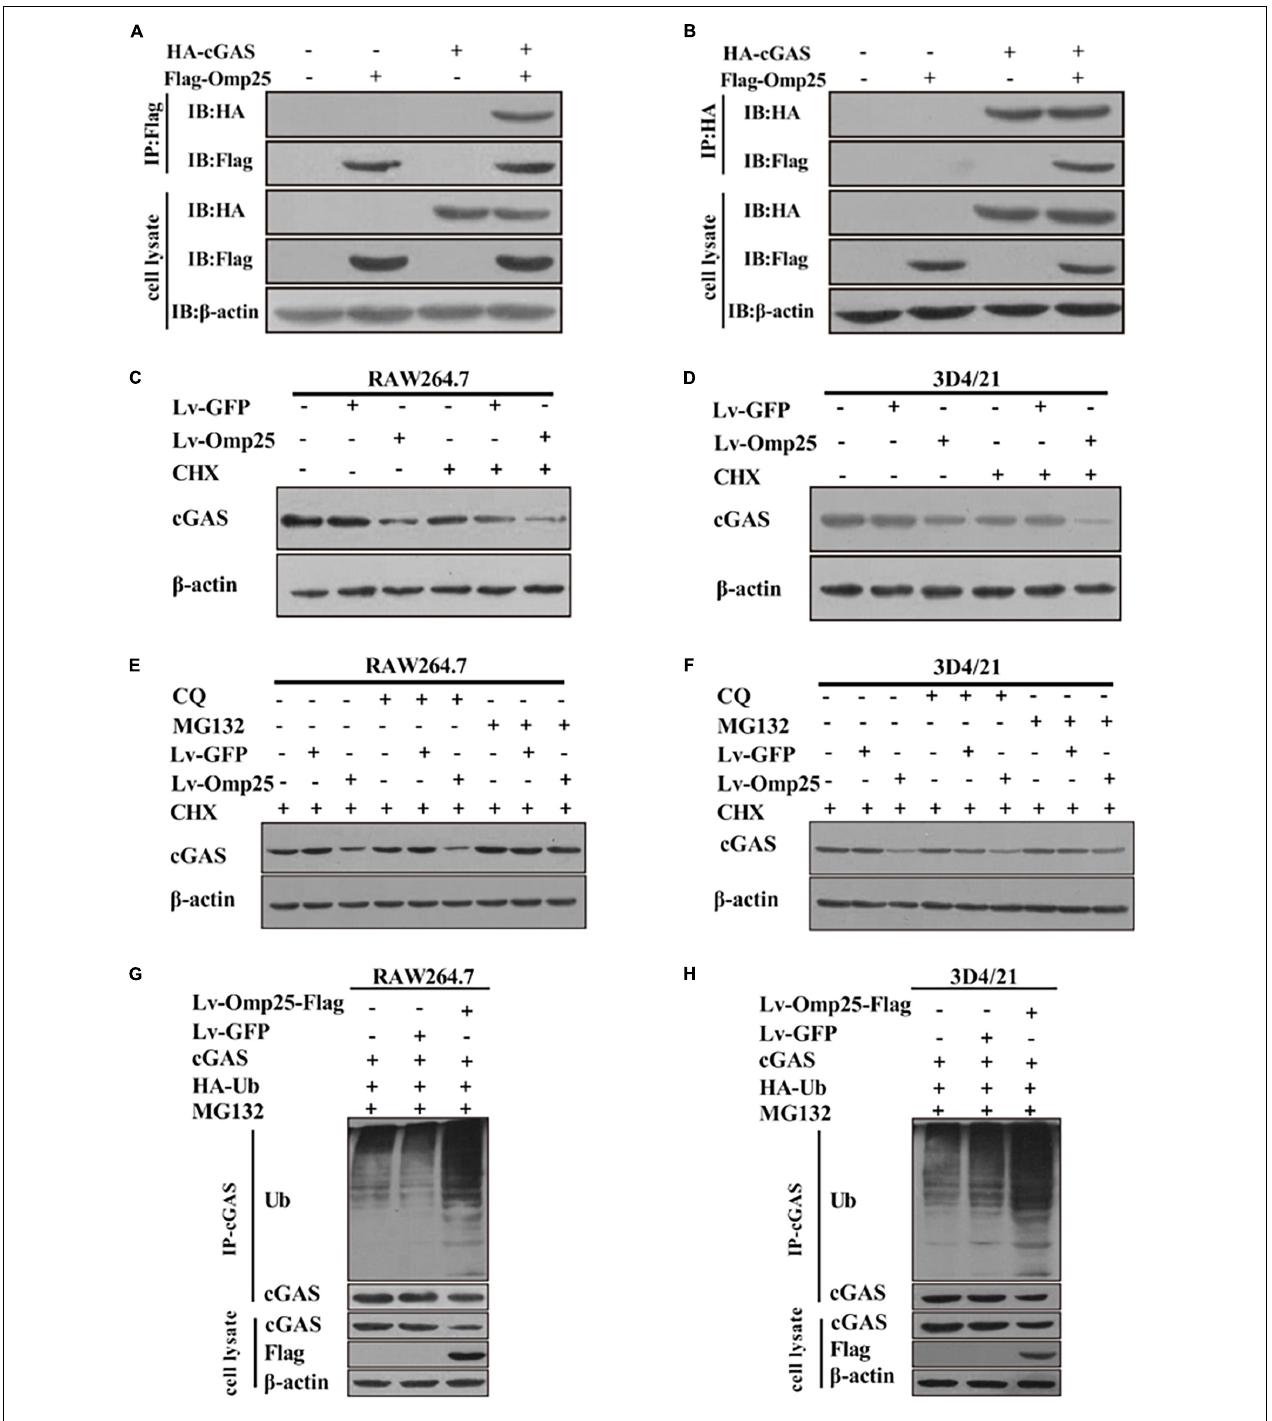
FIGURE 6 | Omp25 reduces level of cGAS protein and induces proteasome-dependent degradation of cGAS. (A , B) Omp25 interacted with cGAS. Cells were co-expressed with Flag-Omp25 and HA-cGAS for 24 h, and cell lysates were subjected to a co-IP assay using anti-Flag antibody, anti-HA antibody, and anti- β -actin antibody. (C,D) Omp25 degraded cGAS in murine and porcine macrophages. RAW264.7 or 3D4/21 cells were infected with 100 MOI of Lv-Omp25 or Lv-GFP for 36 h, then treated with or without CHX (100 µ g/ml) for another 12 h. Level of cGAS was detected by Western blotting. (E,F) Omp25 promoted degradation of cGAS via proteasome-dependent pathway. RAW264.7 or 3D4/21 were infected with 100 MOI of Lv-Omp25 or Lv-GFP for 36 h and treated with dimethyl sulfoxide, CQ (20 µ M), or MG132 (5 µ M) in presence of CHX for another 12 h, followed by Western blotting to detect levels of cGAS. (G,H) Omp25 induced cGAS degradation through ubiquitin–proteasome pathway in RAW264.7 and 3D4/21 cells. Cells were transfected with vector expressing HA-Ub by Lipofectamine 3000 for 24 h, then infected with 100 MOI of Lv-Omp25 or Lv-GFP. At 36-h post-infection, cells were treated with MG132 (5 µ M) for another 12 h; ubiquitination level of cGAS protein was determined by Western